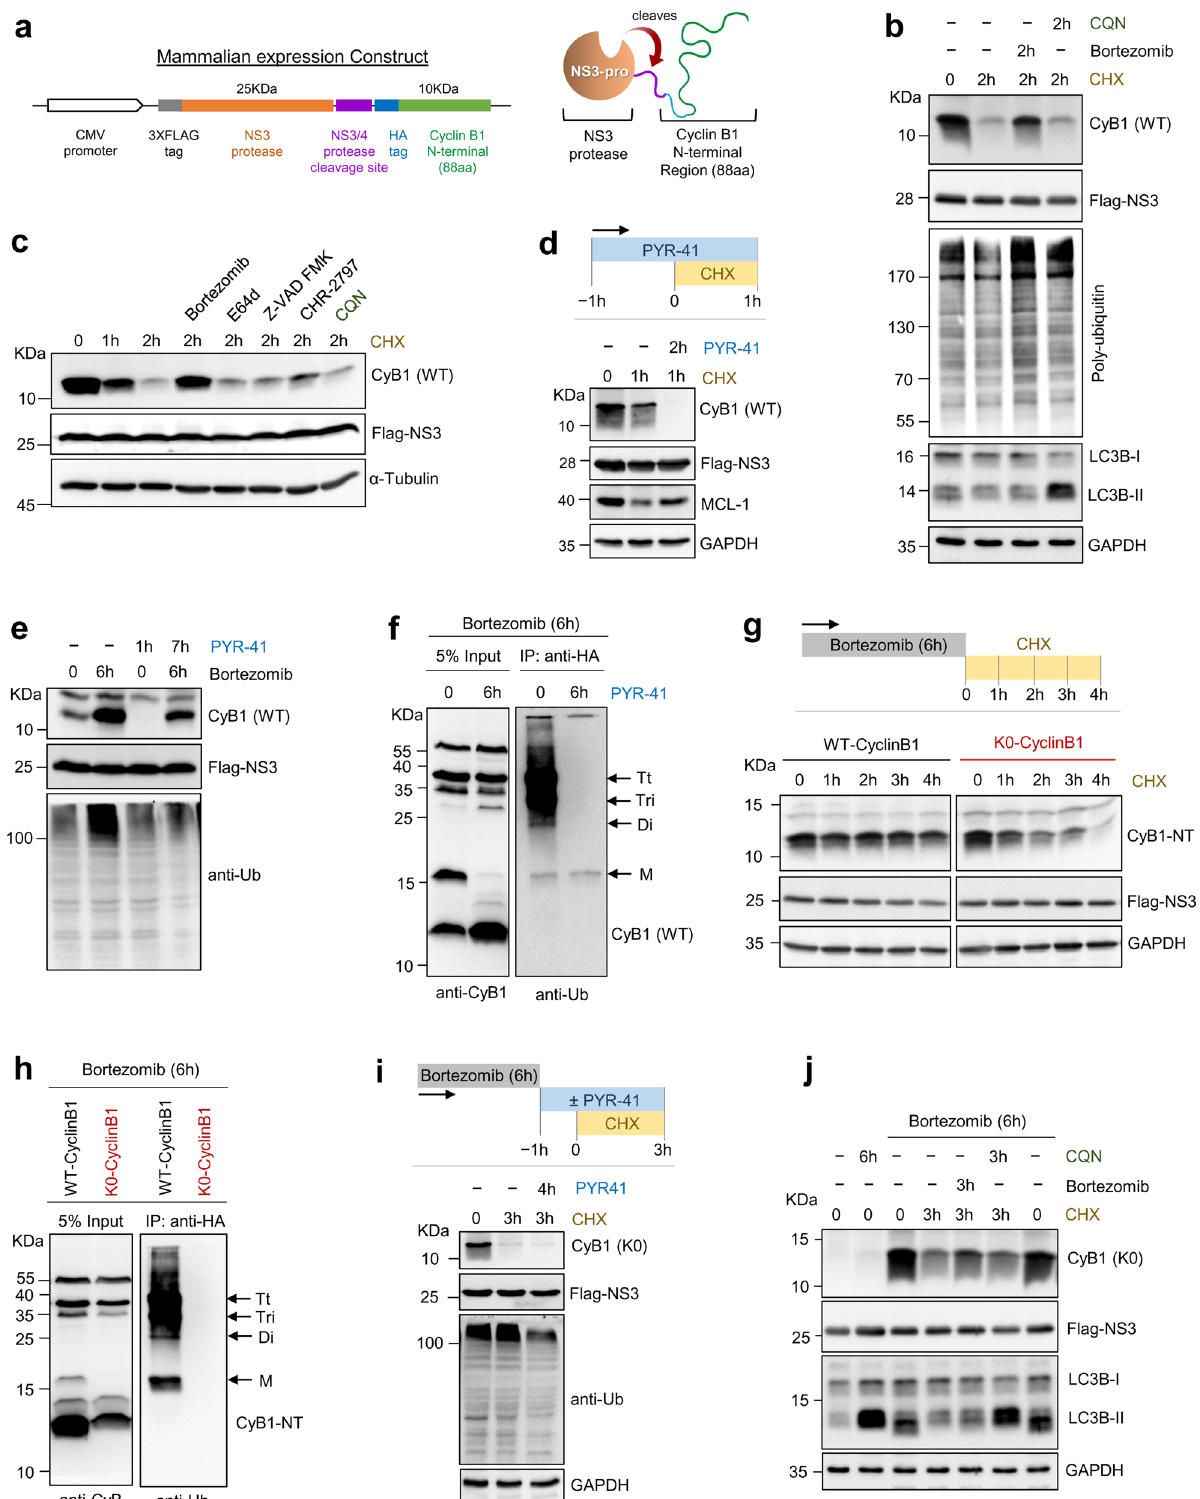
substrate for expression in cell culture by tagging Cyclin B1-NT (1 – 88 aa) with an HA epitope and fusing it N-terminally to a self- immolating NS3-protease (Fig. 5a). After synthesis, cleavage of the stable NS3 domain served as an expression standard (Sup- plementary Methods), whereas the unstructured Cyclin B1-NT segment underwent turnover over rapidly. Proteolysis of the Cyclin B1-NT polypeptide in HEK293T cells was sensitive to a